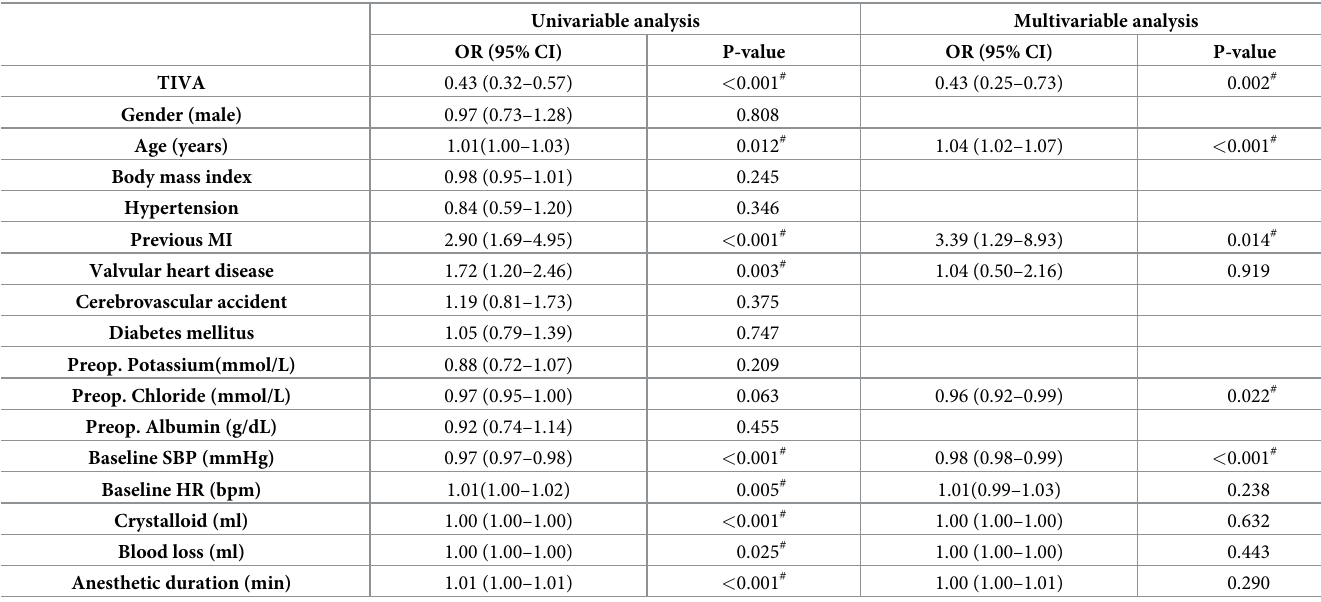
Table 4. Univariate and multivariate